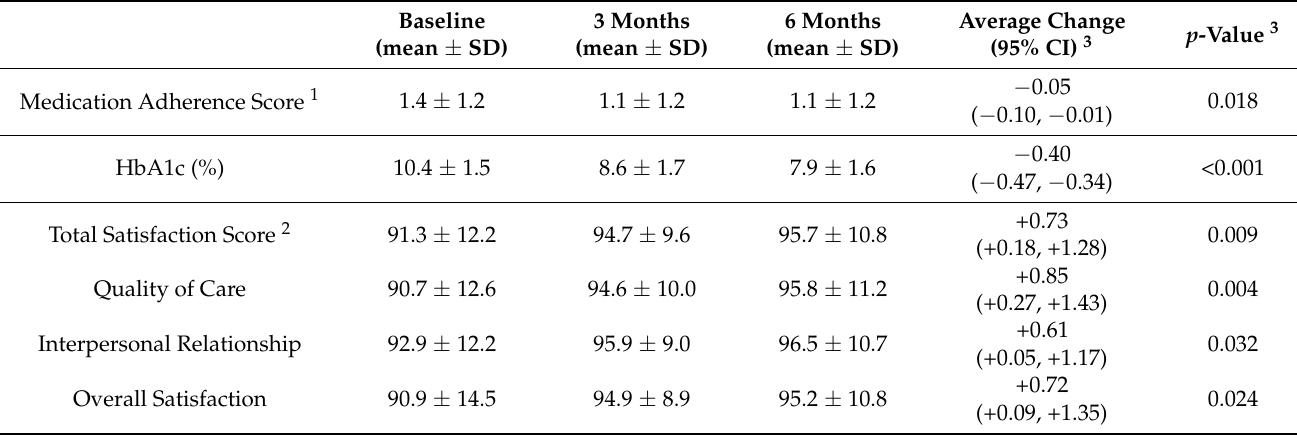
Table 2. Mean medication adherence, HbA1c%, and patient satisfaction at baseline, 3 months, and 6 months (n = 83), mean ±